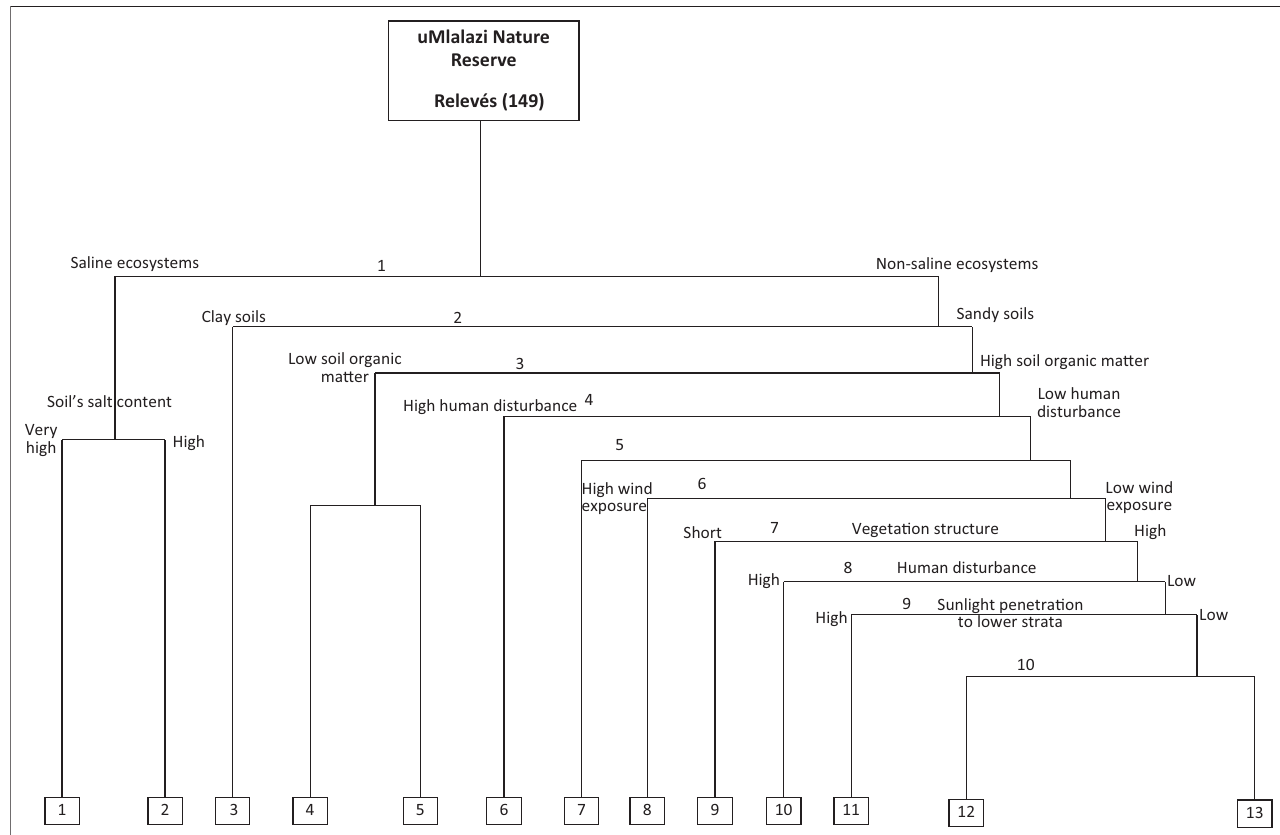
FIGURE 1: Dendrogram illustrating the modified TWINSPAN classification of the vegetation of the uMlalazi Nature Reserve into 13 plant communities.